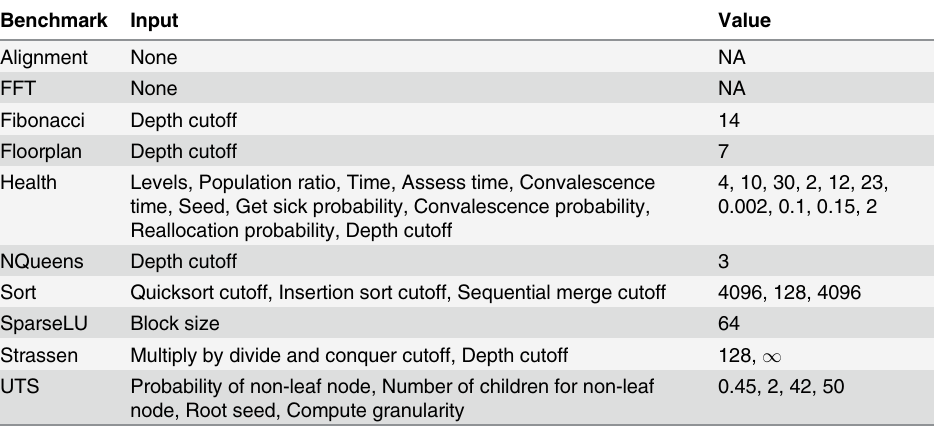
We identify BOTS benchmarks with similar task graph properties and per-task properties using Principal Component Analysis (PCA) and Hierarchical Clustering — techniques common- ly used to identify similarity of computer architecture workloads [21 – 23]. Our similarity analysis provides new directions to extend BOTS and pin-points redundant benchmark-input pairs which when avoided expedites timing-intensive studies such as computer architecture simulation. Table 5. Inputs held constant while studying BOTS input